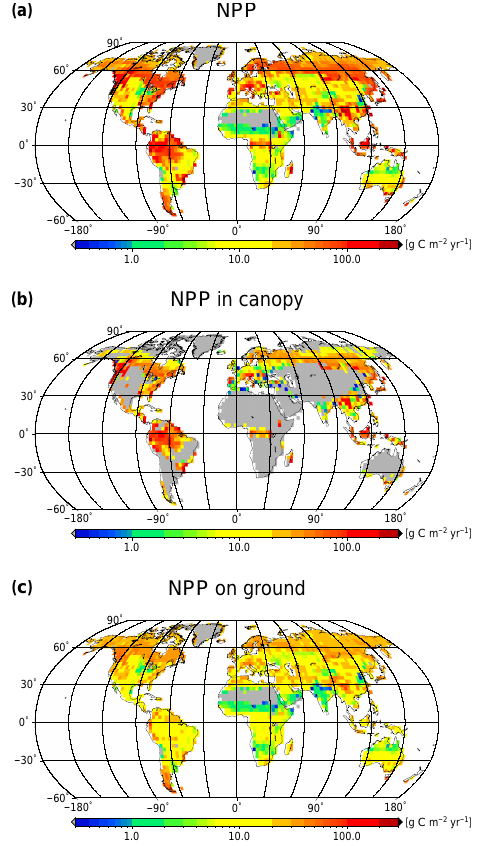
Figure 1. Global patterns of NPP. Lichen and bryophyte NPP esti- mated by LiBry for (a) all locations of growth, (b) the canopy and (c) the ground. The estimates are in grams of carbon per square me- tre, and they are average values over the last 50 years of a 600-year simulation with 3000 initial species. Grey colour denotes regions where no simulated species is able to survive, such as ice shields and the driest regions of